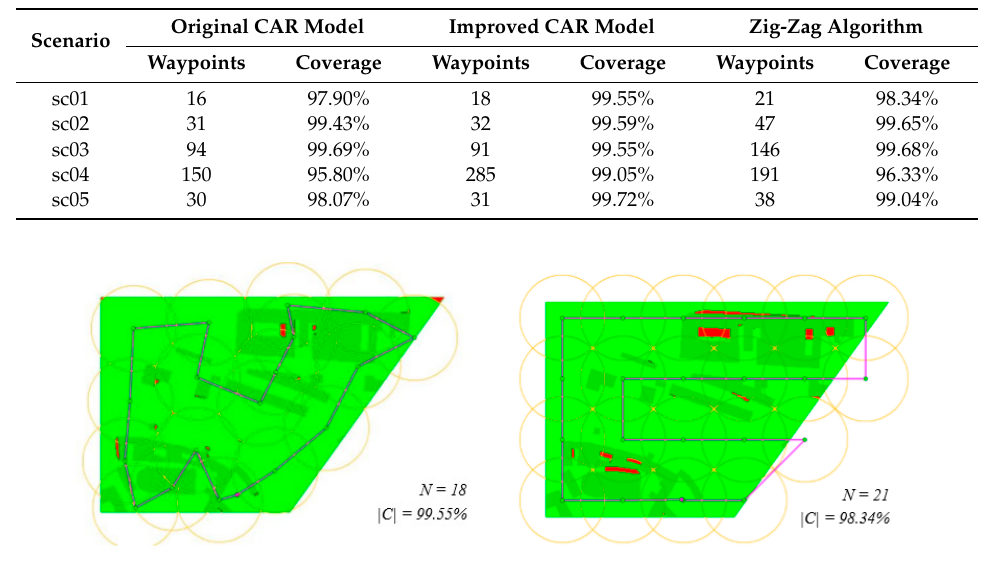
Table 6. Monitoring enabled during a flight.